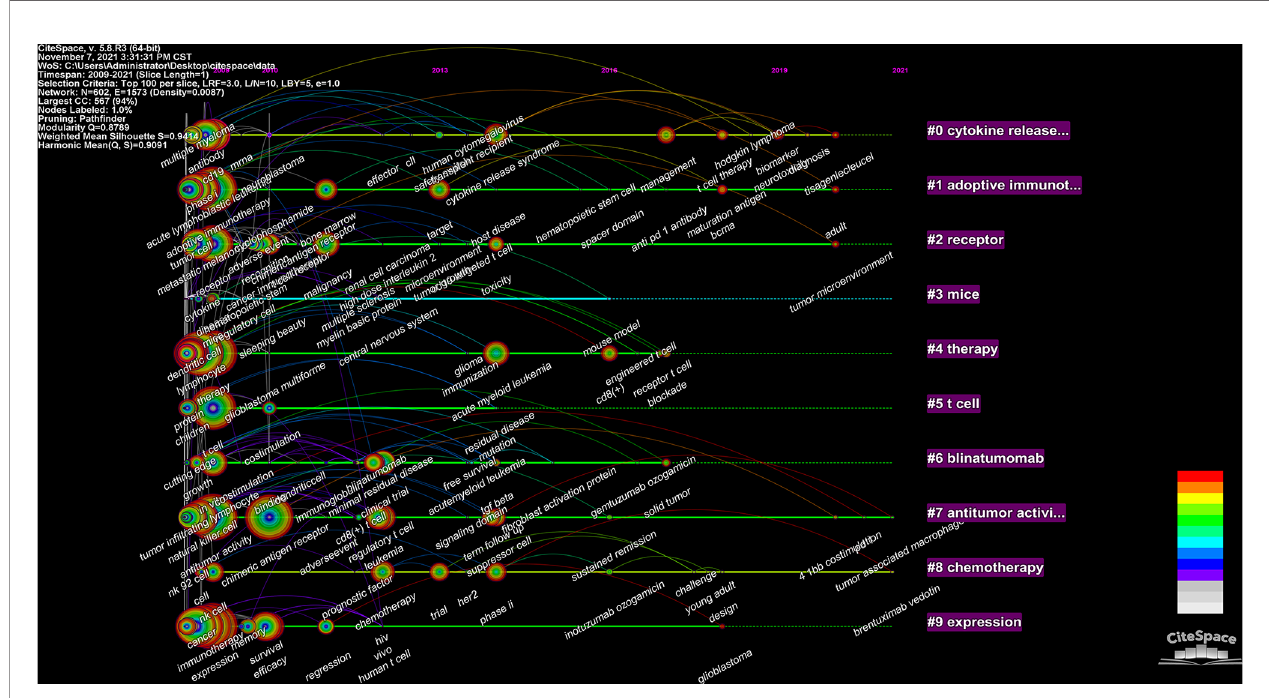
FIGURE 9 | CiteSpace visualization map of timeline viewer related to CAR-T